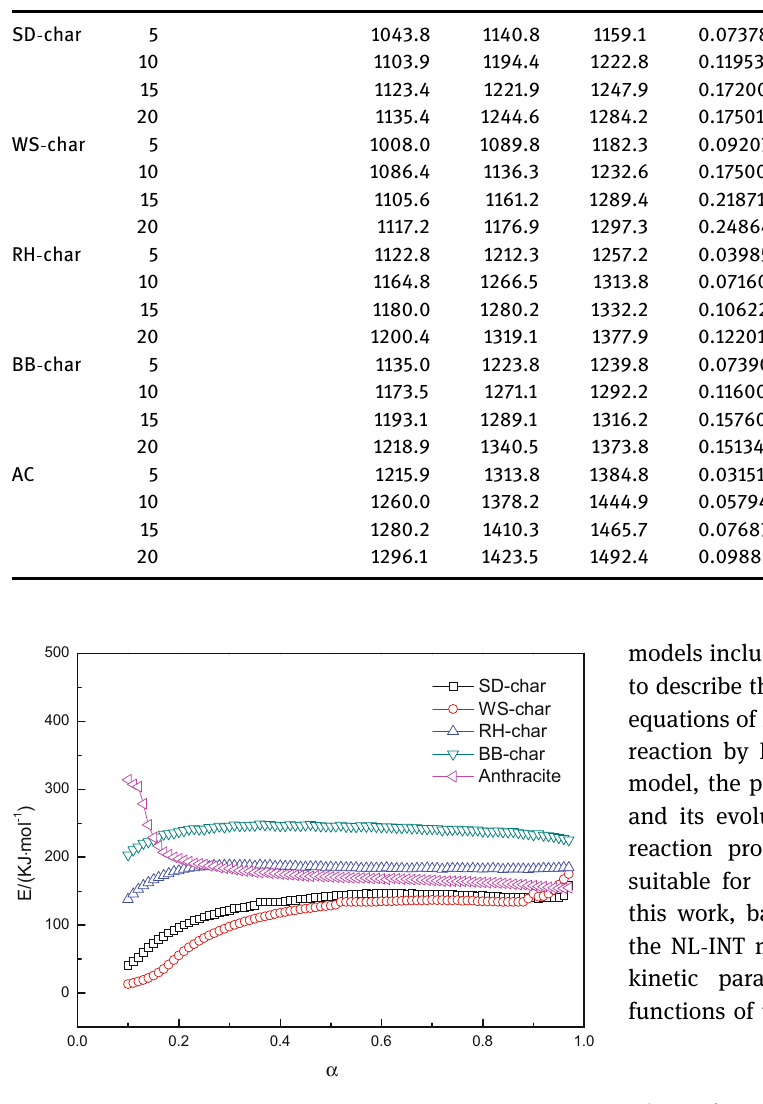
Table 2: Gasi fi cation characteristic parameters of di ff erent samples Samples